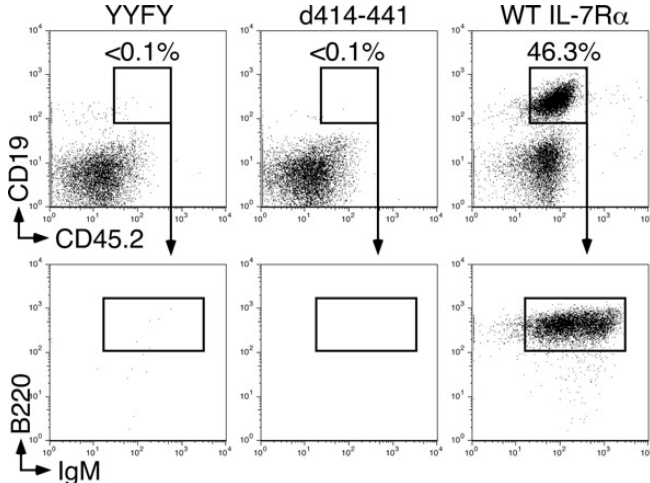
Figure 3. The d414–441 mutant did not support B-cell development in vivo. We infected IL-7Rα −/− KLS cells (CD45.2) with recombinant viruses, as indicated in the figure. GFP-positive cells were purified and injected into 400 rad-irradiated RAG2 −/− (CD45.1) mice intravenously. Four weeks after injection,